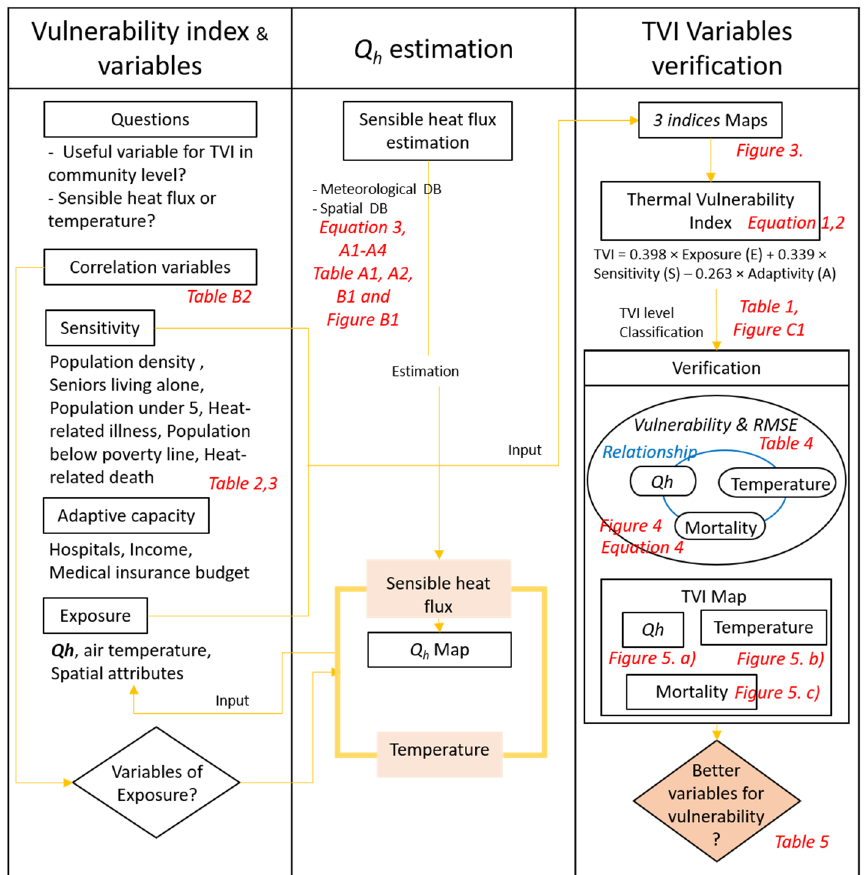
Figure 2. Flow chart of research methods.